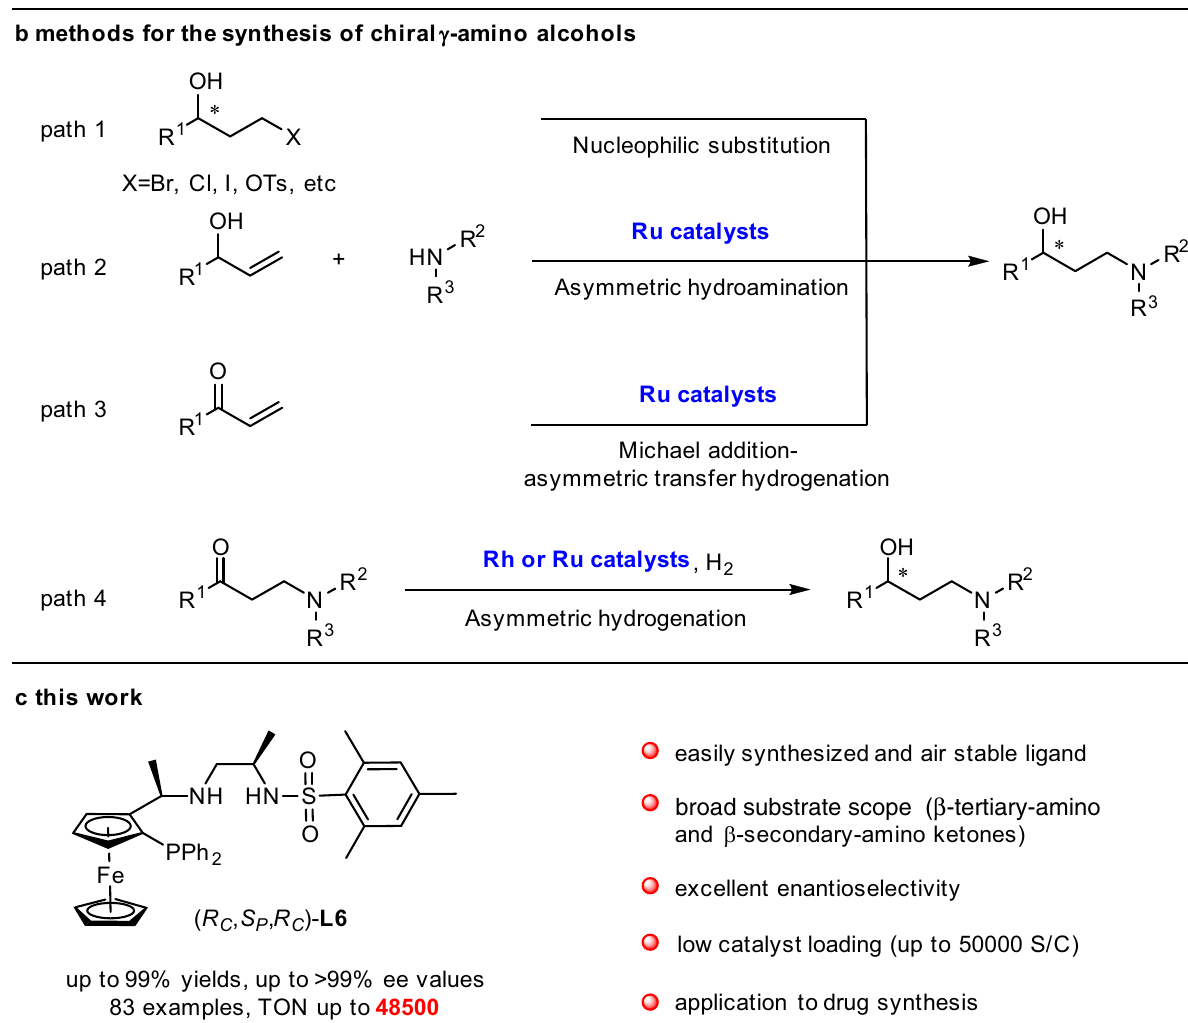
Fig. 1 The designed ligand for asymmetric hydrogenation of β -amino ketones. a Drugs and potential analgesic agent containing γ -amino alcohol units. b Methods for the synthesis of chiral γ -amino alcohols. c The designed ligand for asymmetric hydrogenation of β -amino